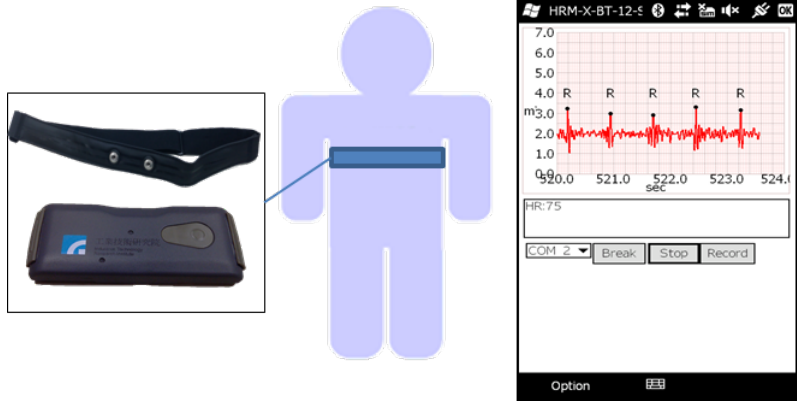
Figure 16. The algorithm implementation in a wearable heart rate sensor .